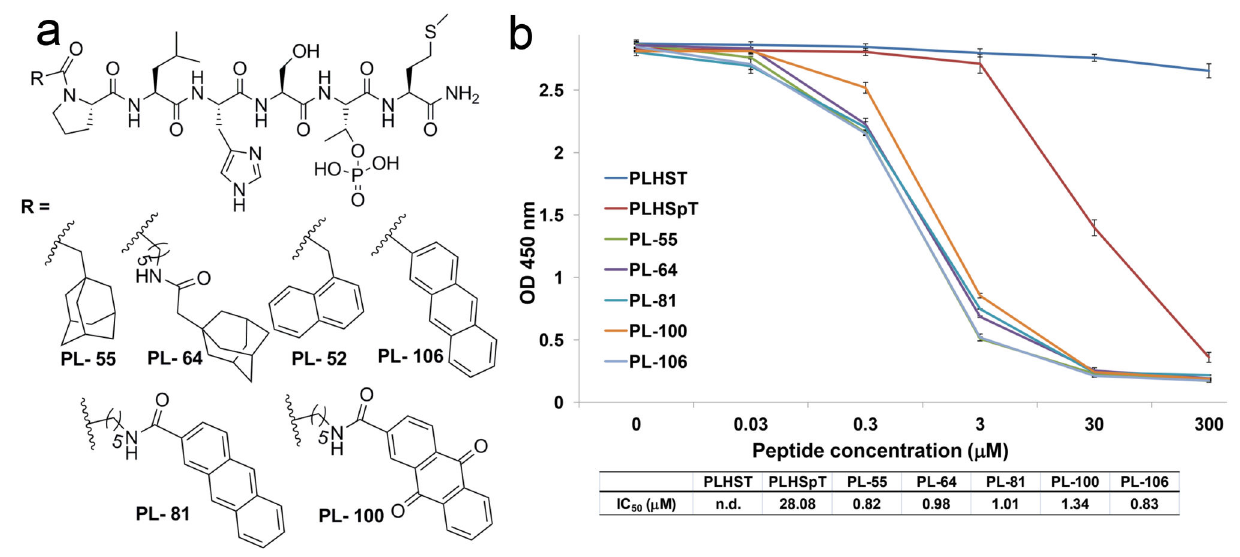
Figure 6. Selected N- terminal peptide derivatives synthesized from the second-phase diversification and quantification of their inhibitory activities against Plk1 PBD. (A) Second-phase N-terminal-truncated PLHSpTM peptide derivatives generated using solid-phase peptide synthesis (SPPS) to study the binding nature of the pyrrolidine-binding region. (B) ELISA-based Plk1 PBD-binding IC graph (O.D., optical density). A representative graph from three independent experiments. 50